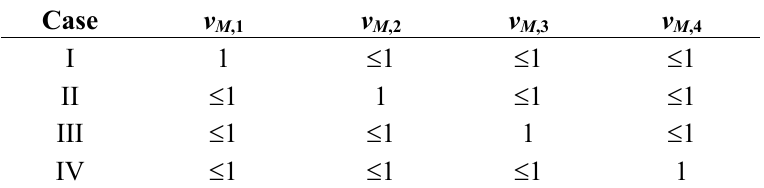
Table 2. Four combinatorial cases for Kim et al .’s E. coli model.